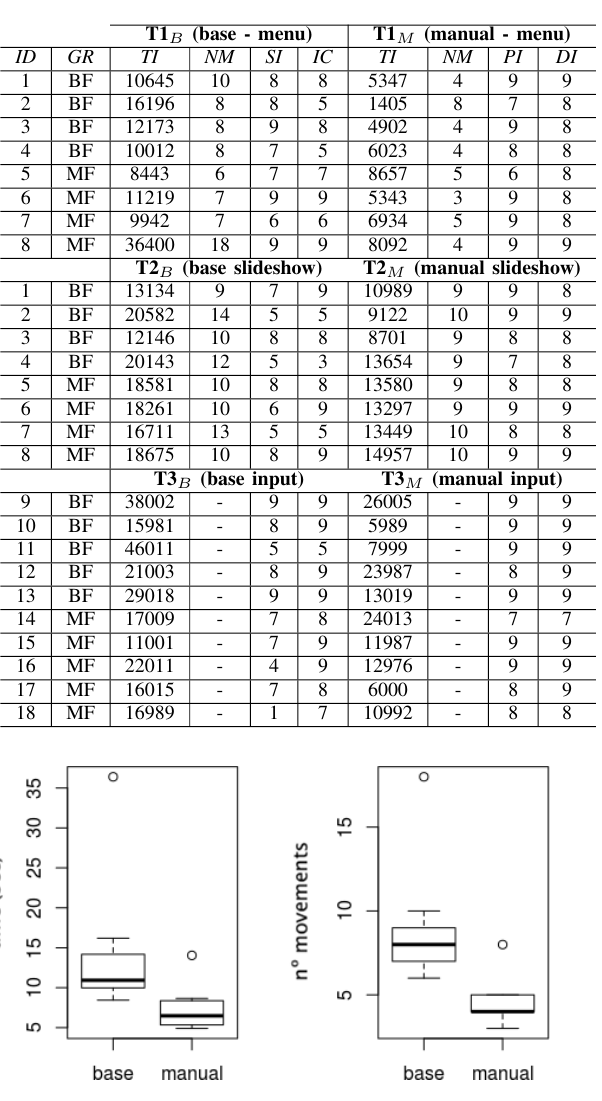
Fig. 1. Boxplots of task T1 to menu comparing the metrics of time and movements.